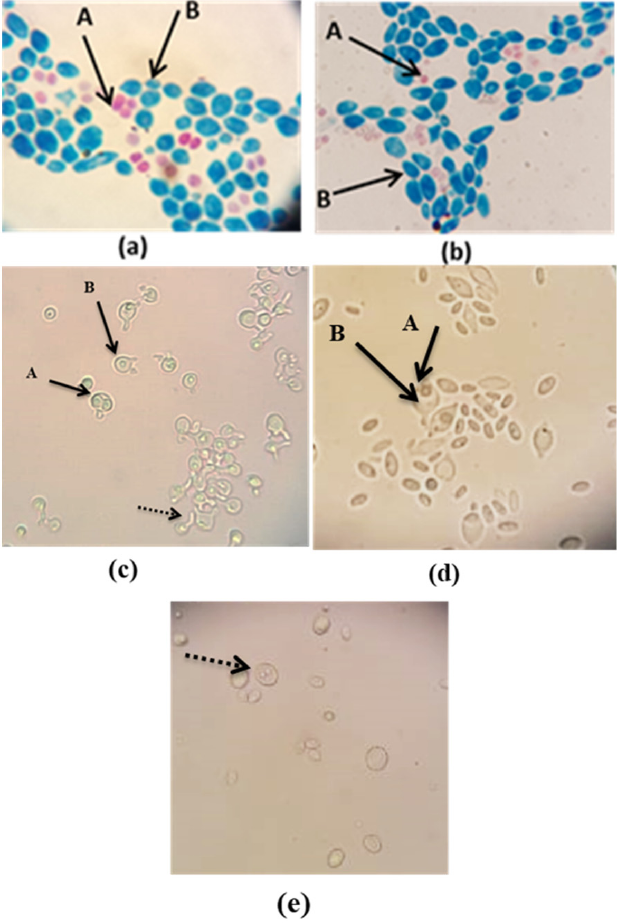
Figure 2. Highlighting the ability to form ascospores on medium with calcium carbonate as a non-fermentable carbon source ( a , b ) (100×), using specific staining with fuchsin and methylene blue or 5% malt agar medium ( c – e ); ( a )—MD3; ( b )—MS1-1; ( c ) M5; ( d ) M1; ( e ) M3. A: ascospore; B: ascus; (40×); dashed arrow indicates specific cellular modifications. Table 1. Conventional test results obtained for yeasts isolated from wine wort and automatized taxonomical identification using the Biolog Microbial ID System and Bruker Maldi-TOF.